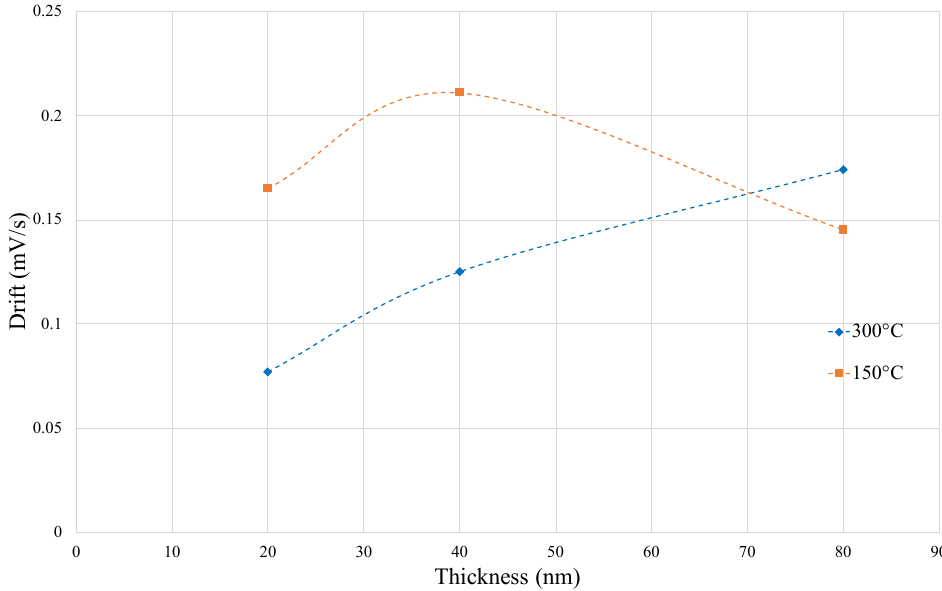
Figure 9. Drift versus thickness in two different